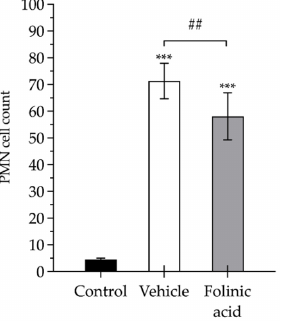
Figure 4. Polymorphonuclear neutrophil (PMN) inflammatory cell count in the gastrocnemius muscles of healthy control animals (control, black bars) and animals subject to 3 h of ischemia and 24 h of reperfusion and treated with saline (vehicle, white bars) or treated with folinic acid (gray bars). The pads show the statistically significant differences between the groups indicated by the upper box (## p < 0.01), and the asterisks show the statistically significant differences compared to the control (*** p < 0.001).